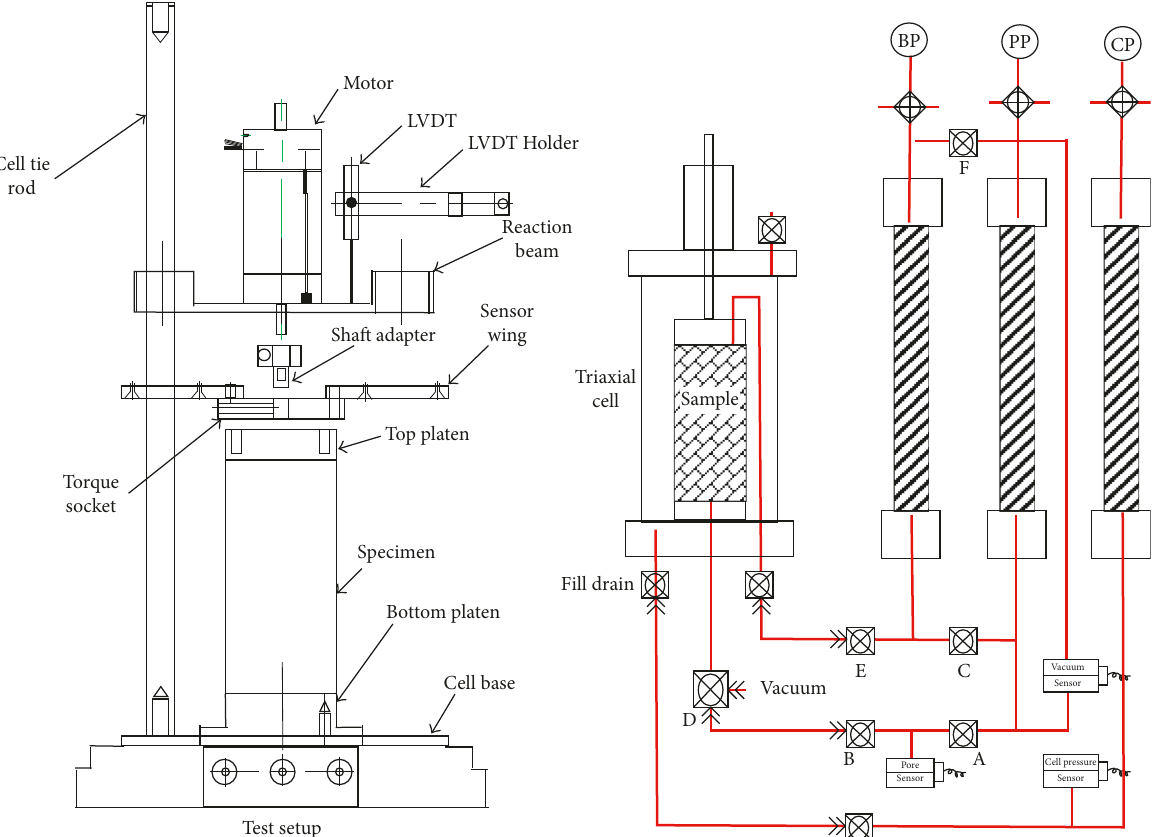
Figure 3: Schematic diagram of the resonant column/torsional shear